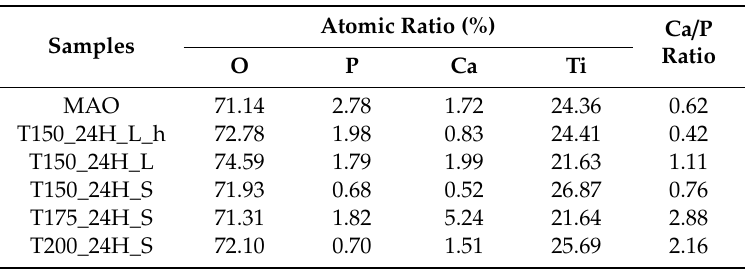
Figure 3. The Energy-Dispersive X-ray Spectrometer (EDS) measurement was performed on the surface of the sample. ( a ) Sample T175_24H_S was scanned in low magnification and ( b ) the EDS spectrum was collected.